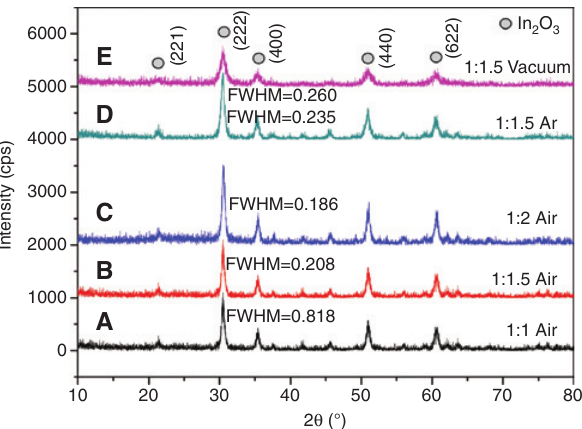
O prepared by annealing in air with 2 3